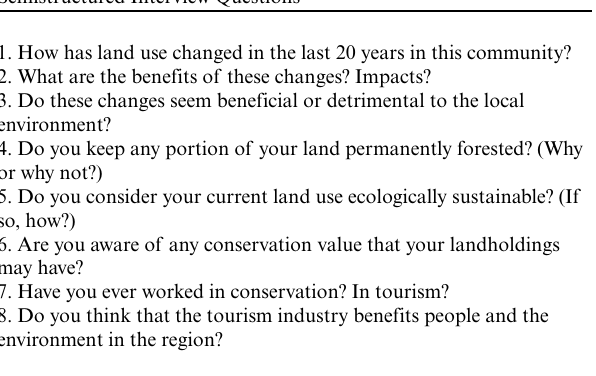
Table 2 . The following questions were analyzed for all people interviewed. Responses are consolidated in Tables 3 and 4.